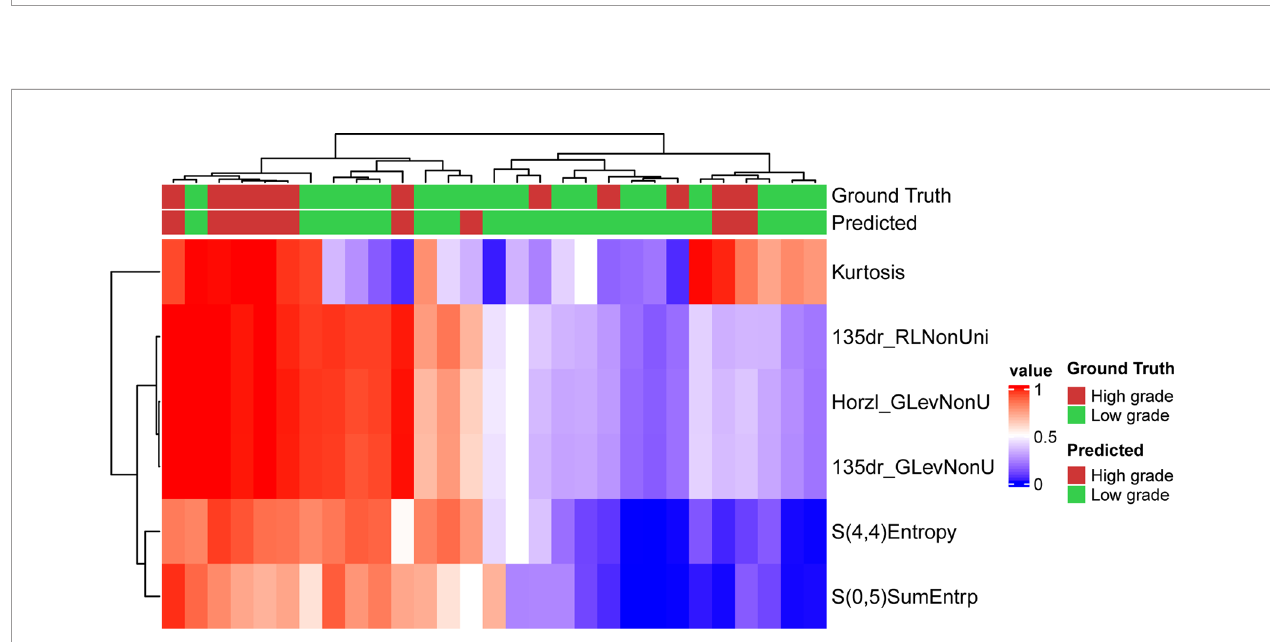
FIGURE 3 | The receiver operating characteristics curves of the classi fi er applied to the training set and validation set. The area under curve is 0.997 in the training dataset and 0.758 in the validation set.